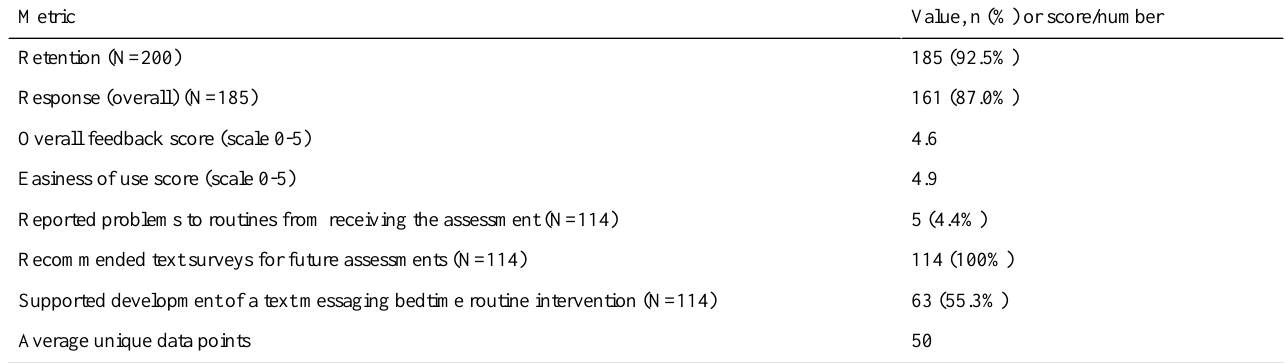
Table 3. Key results of the study.